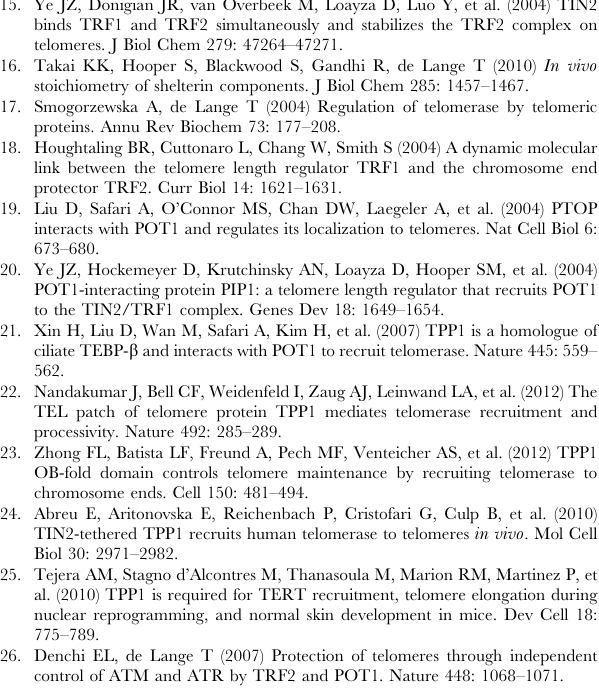
Table S1 Telomere length correction factors (telomere/rDNA). Table S2 Fission yeast strains used in this study. Table S3 Plasmids used to integrate tpz1 mutant alleles into fission yeast. Table S4 Plasmids used in yeast 2-hybrid assays. Table S5 Statistical analysis of ChIP and TER1 co-IP data by 2- tailed Student’s